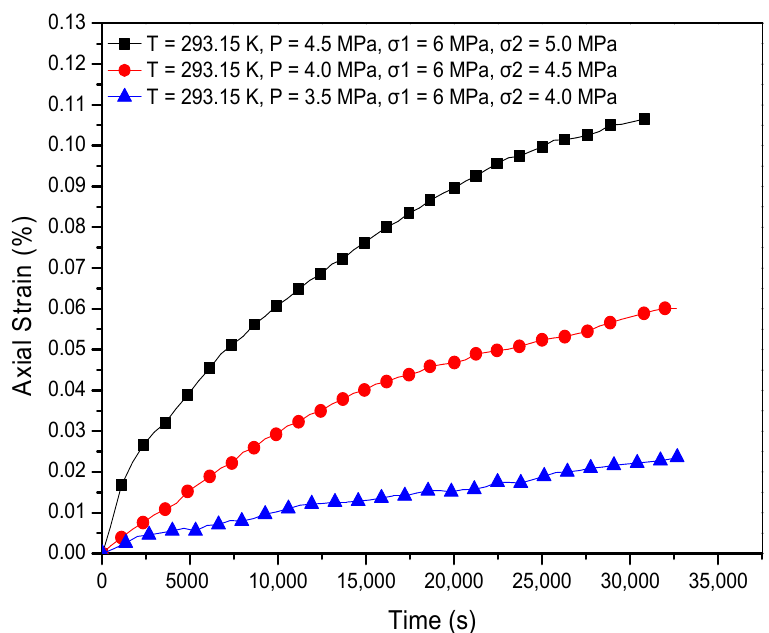
Figure 7. Variation of axial adsorption strain of coal samples under different axial effective stresses at 293.15